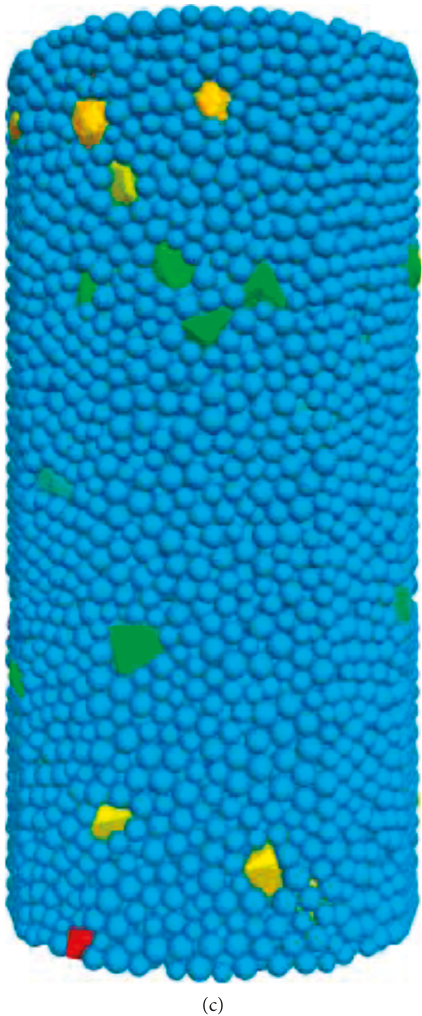
Figure 10: Three-dimensional model of rubble spatial random location distribution under the same rock content: (a) random position 1; (b) random position 2; (c) random position